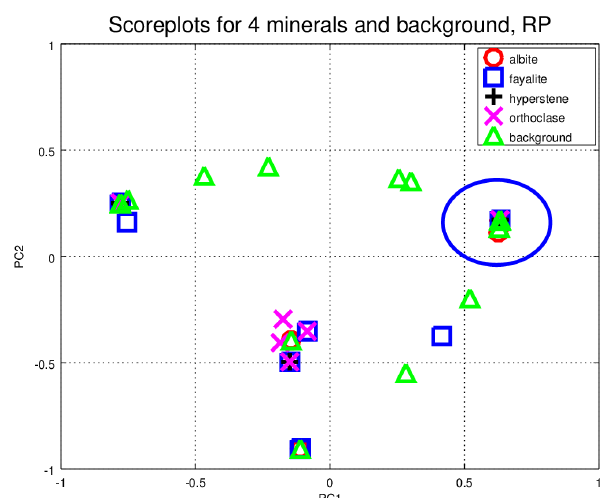
Figure 8. Score plot using the two first PCA components from RP projection of full spectra. The events represent the four minerals and the background for substrate 496. The circled region is magnified in Fig. 9.